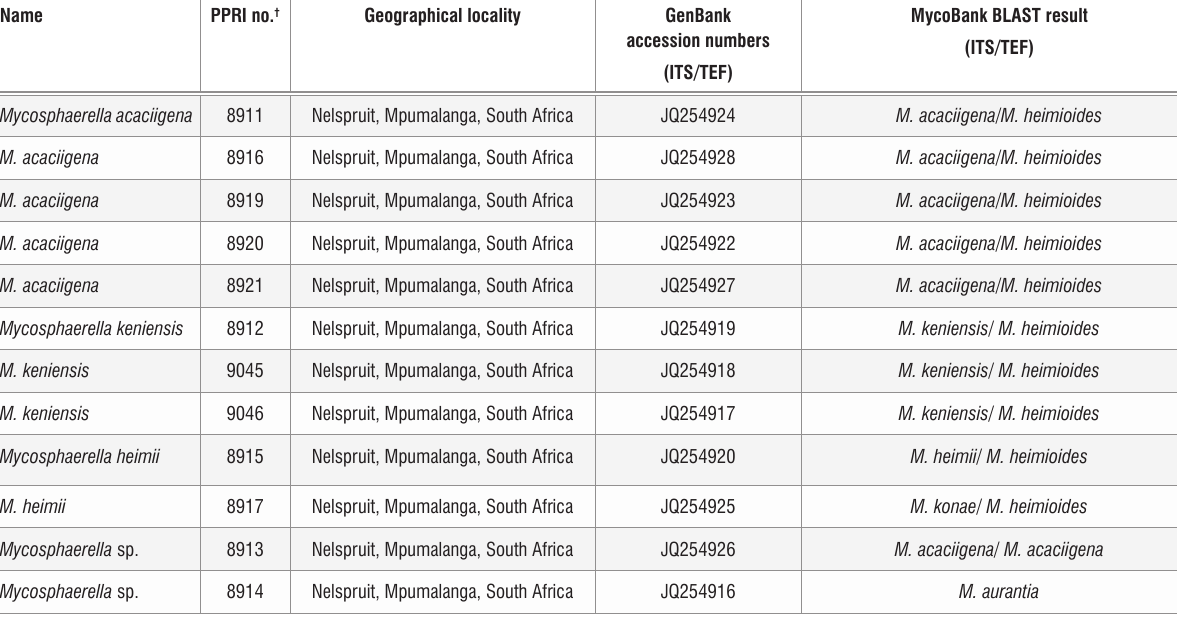
Mycosphaerella isolates from infected guava fruit used in this